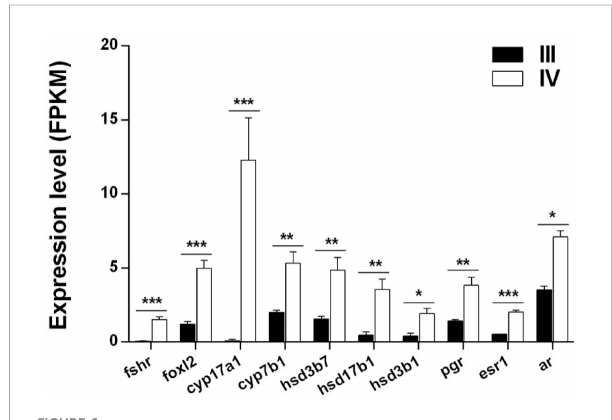
FIGURE 6 Histogram showing the expression of DEGs (log2 (FC) >1 and FDR <0.05) involved in steroid hormone synthesis in stage III and IV ovarian growth and development of S. argus . The data is based on the FPKM values obtained from the RNA-seq data. *, P<0.05; **, P<0.01; ***, P<0.001.